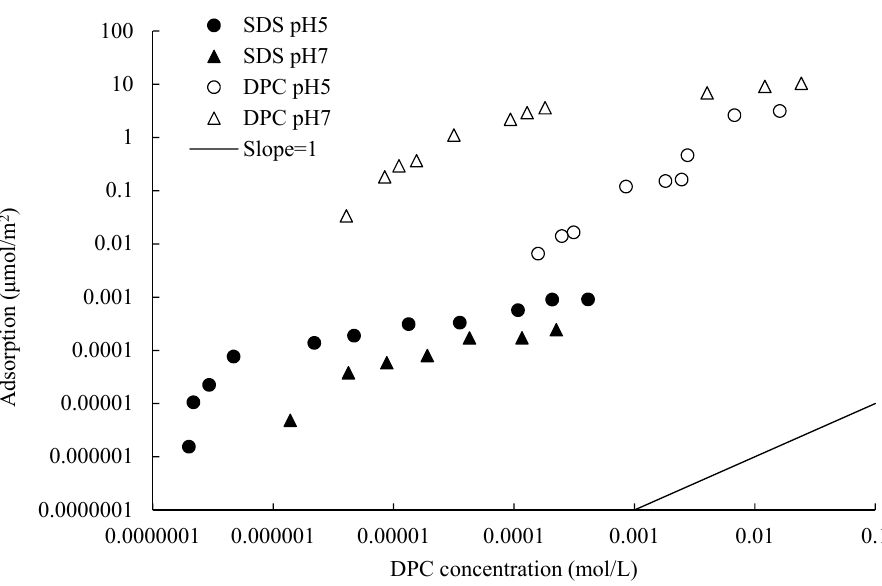
Figure 11. Isotherms of SDS and DPC adsorption on silica at 0.1 mol/L of NaCl solution and different pH. SDS adsorption isotherm comes from Li and Ishiguro (2016).